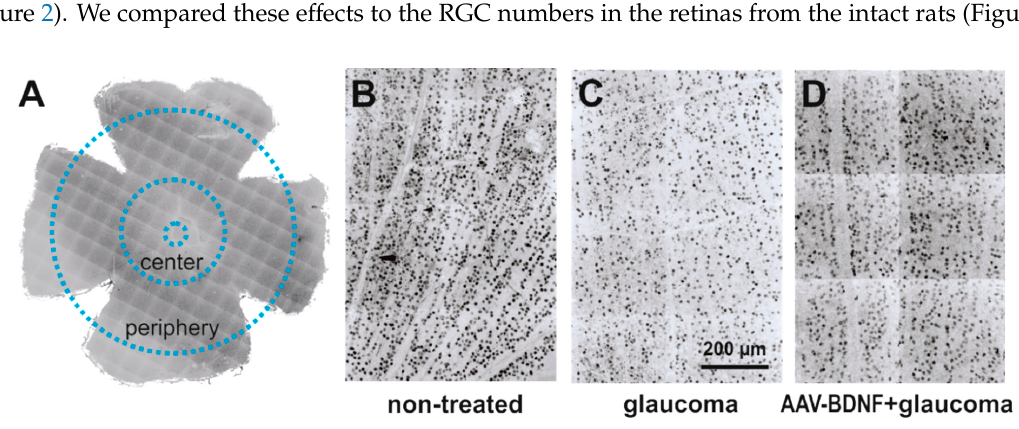
( A ) ( B ) Figure 3. The effect of glaucoma (blue) and AAV2-BDNF treatment (orange) on the number of RGCs in central ( A ) and peripheral ( B ) fields of the retina six weeks after glaucoma induction. Dark color bars refer to the Right, glaucomatous eye. Light color bars mark the Left fellow eye. Data are shown as mean ± SD from 8 (glaucoma group) and 7 (AAV2-BDNF+ glaucoma group) rats. Two-way RM ANOVA, Sidak’s post-hoc test; *** p < 0.001, ** p < 0.01, * p < 0.05. In naive animals, the number of RCGs per mm 2 amounted to 1686 ± 30 in the central retina, and to 1250 ± 133 in the peripheral zone (mean ± SD from three rats; five retinas). After 6 weeks, the rats with glaucoma induction showed a 31% loss of RGCs in the central retina of the glaucomatous eye, as compared to the fellow eye (two-tailed ANOVA test with multiple comparisons, post-hoc Sidak test, F (1,13) = 172.6, p < 0.001; Figure 3A, blue). The number of RGCs per mm 2 in the glaucomatous retina amounted to 1071 ± 137, while in the contralateral retina it was 1556 ± 145. In rats which received BDNF transgene, the loss of RGCs in the glaucomatous retina ( p < 0.001) was markedly reduced (to approx. 15%) as compared to rats with no BDNF gene transfer (two-tailed ANOVA test with multiple comparisons, post-hoc Sidak test, p = 0.0038; Figure 3B, orange). In the AAV2-BDNF-treated group, the density of RGCs in the glaucomatous retina amounted to 1267 ± 60, while in the contralateral retina it was 1500 ± 49. The importance of BDNF overexpression for the